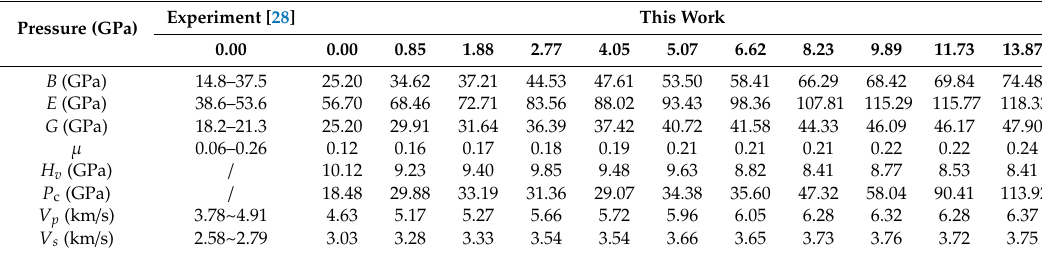
Table 5. The calculated bulk modulus ( B ), Young’s modulus ( E ), shear modulus ( G ), Poisson’s ratio ( µ ), Vickers hardness ( H v ), Cauchy pressure ( P c ), compression wave velocity ( V p ) and shear wave velocity ( V s ) of pyrophyllite [Al 4 Si 8 O 20 (OH) 4 ] under di ff erent pressure, compared with experimental data.